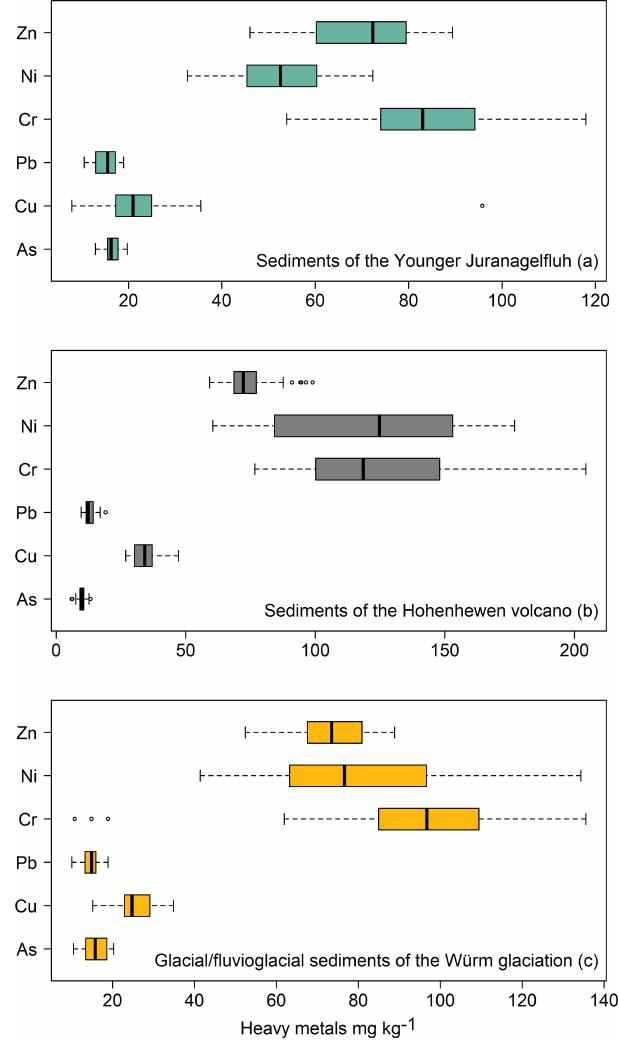
Figure 12. Heavy metal contents of the soil profiles ABR W1, ABR W2, ABR M, ABR S30, ABR SA1 and ABR SA2 accord- ing to their soil substrates: (a) sediments of the Younger Juran- agelfluh ( n : 113); (b) sediments of the Hohenhewen volcano ( n : 93); (c) glacial/fluvioglacial sediments of the Würm glaciation ( n : 38). The box plots show median, 25th ( Q 1 ) to 75th ( Q 3 ) percentile (i.e., interquartile range, IQR), data minimum ( Q 1 − 1 . 5 × IQR), data maximum ( Q 3 + 1 . 5 IQR) and